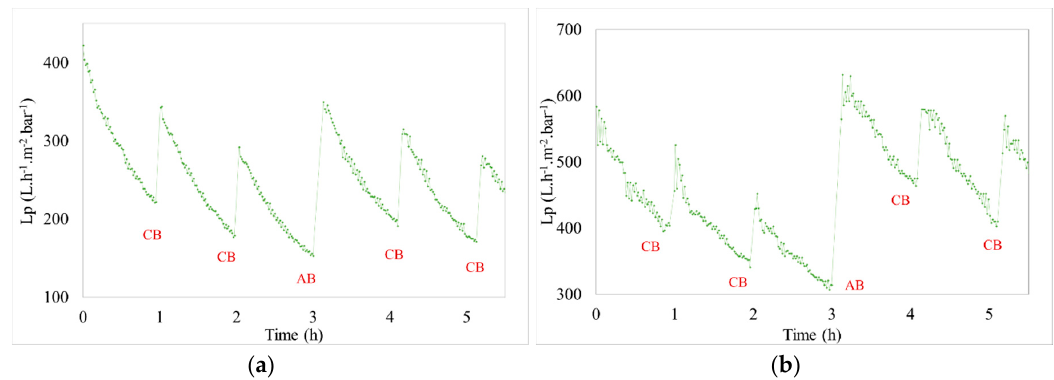
Figure 6. Variation of permeability vs. time (J = 60 L h − 1 m − 2 and t filtration = 60 min; accidental pollution) ( a ) [oocytes] feed = 300 oo mL − 1 and ( b ) [spermatozoa] feed = 200,000 spz mL − 1 .